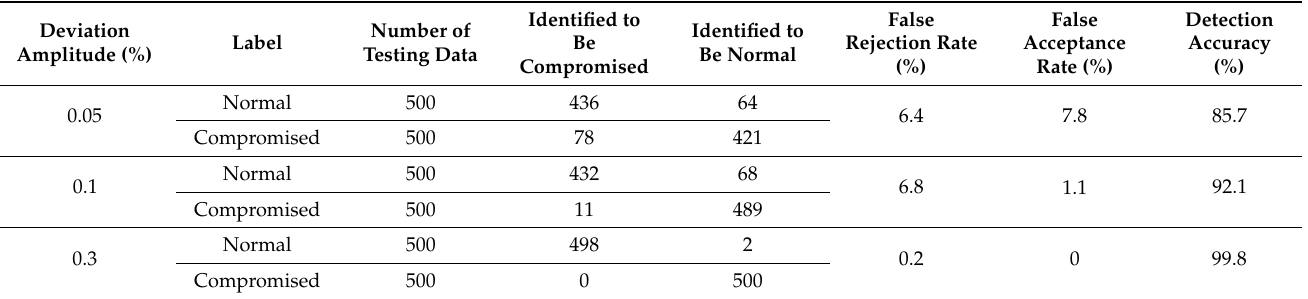
Table 3. Results of the proposed model for FDI attack detection in the IEEE bus-14 system. Deviation Amplitude (%)